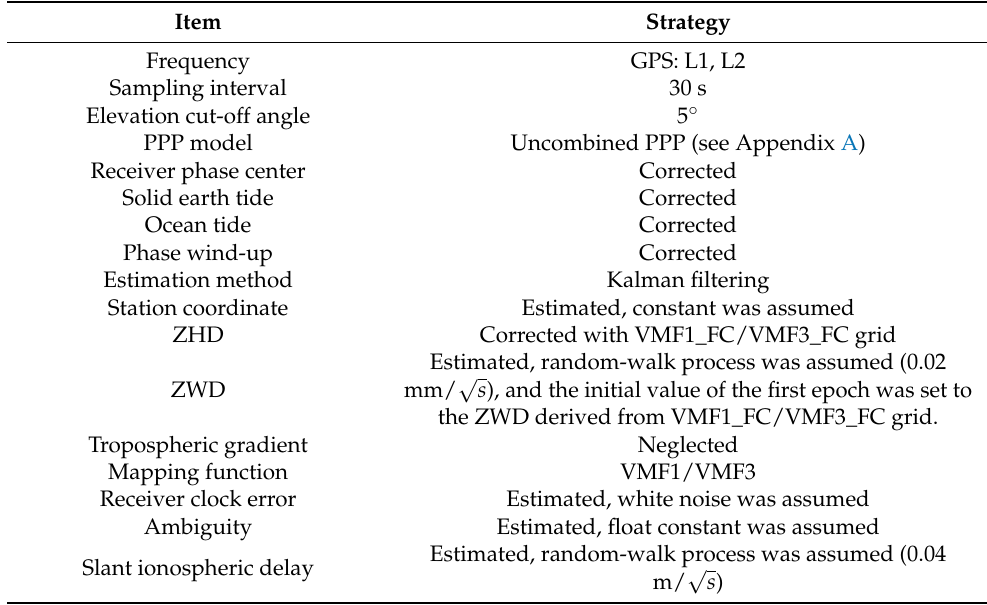
Figure 1. Distribution of 41 selected IGS stations. Table 1. Processing strategies of RT-PPP.